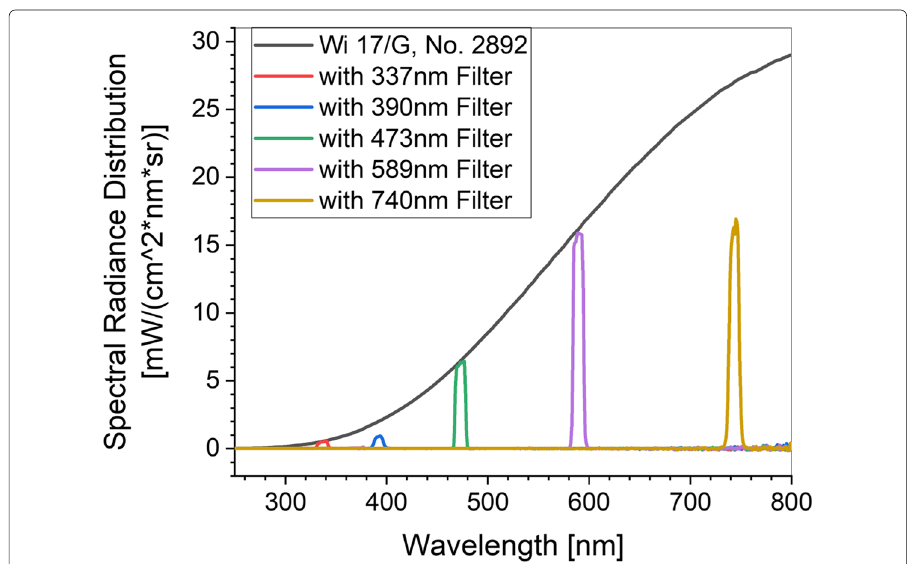
Fig. 6 The spectral distribution of the light which is used for the calibration of the detector systems is shown. The black curve shows the emission of the calibration lamp versus the wavelengths. The individual peaks show the multiplication of the curves with the filter transmission